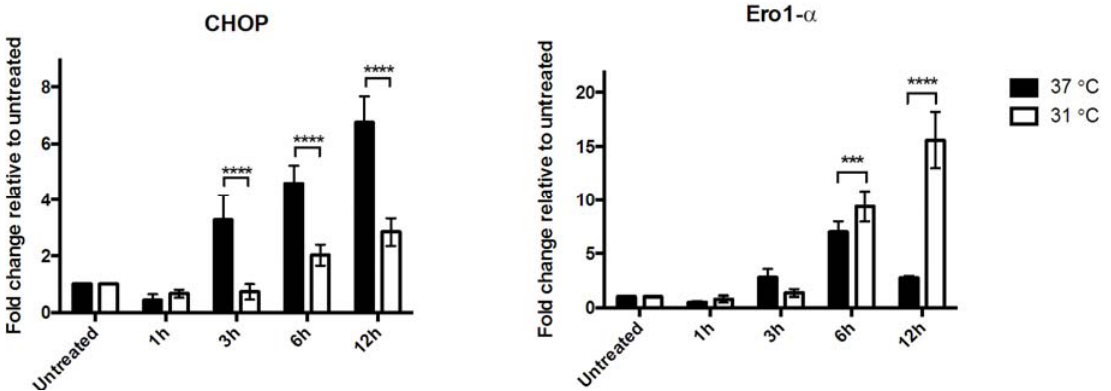
Figure 3. Expression of CHOP and Ero1- α in hypoxic PC12 cells under normo- and hypothermic conditions. Quantitative PCR revealed increased expression levels of CHOP and Ero1- α over a 12 h time course under normothermic conditions. This is consistent with findings in the global ischemia in vivo model. Hypothermia attenuated the expression of CHOP significantly ( p < 0.0001) at 3 ( n = 6), 6 ( n = 5) and 12 h ( n = 5). The expression levels of Ero1- α were augmented by hypothermic conditions with marginally increased levels at 6 h ( n = 6) and significantly increased levels at 12 h ( n = 5). *** p < 0.001 and **** p <